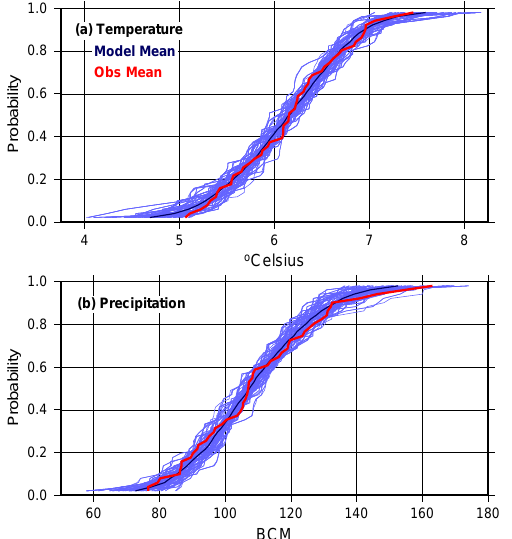
Fig. 4. Projected evolution of climate in the Upper Colorado River Basin above Lees Ferry, Arizona. Shown are 30-yr averages (trail- ing) of climate for (a) temperature and (b) precipitation. Precipita- tion is reported as the total volume falling in the